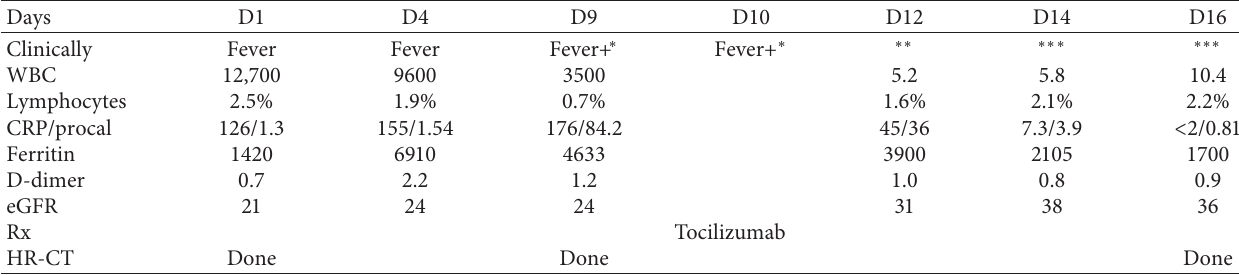
Table 1: Clinical and laboratory data before and after tocilizumab